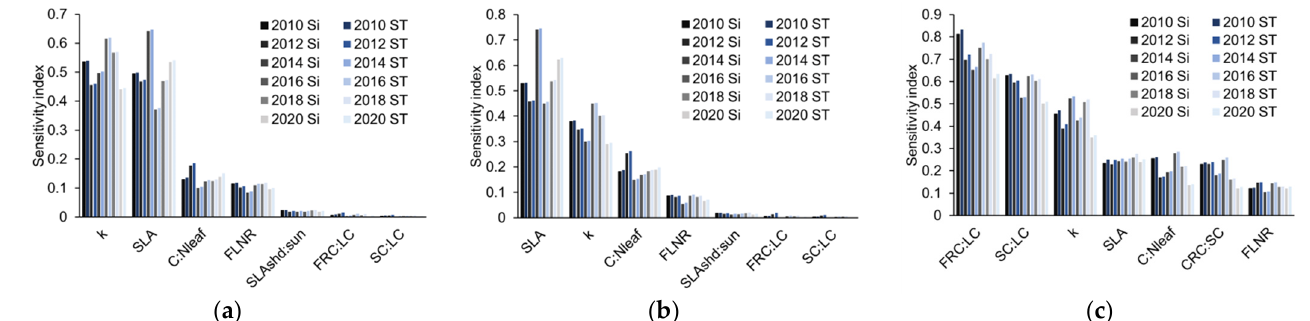
Figure 1. First-order sensitivity index (S i ) and total sensitivity index (S Ti ) of key parameters during 2010–2020 with different outputs: ( a ) with NEE as the output; ( b ) with GPP as the output; ( c ) with LAI as the output.